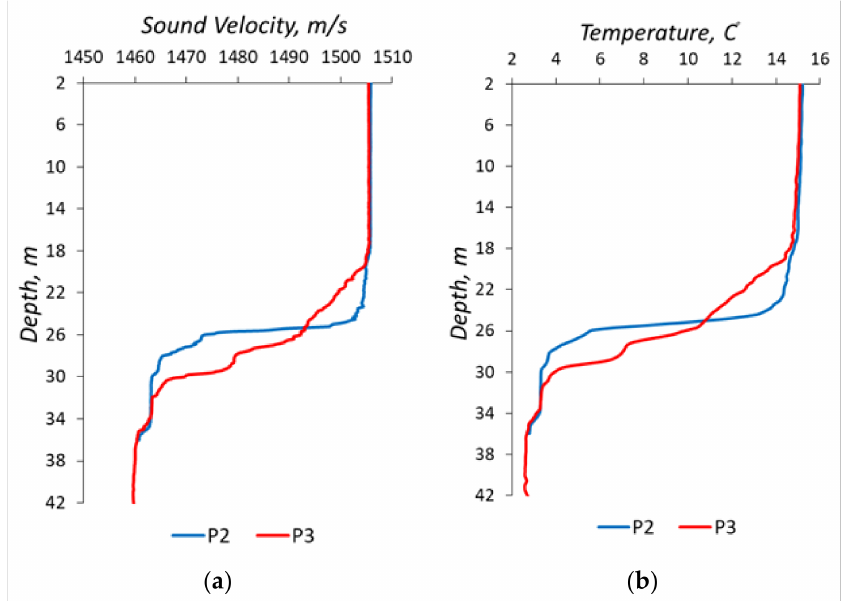
Figure 6. Vertical distributions of the sound velocity ( a ) and the temperature ( b ) at measurement points P2 and